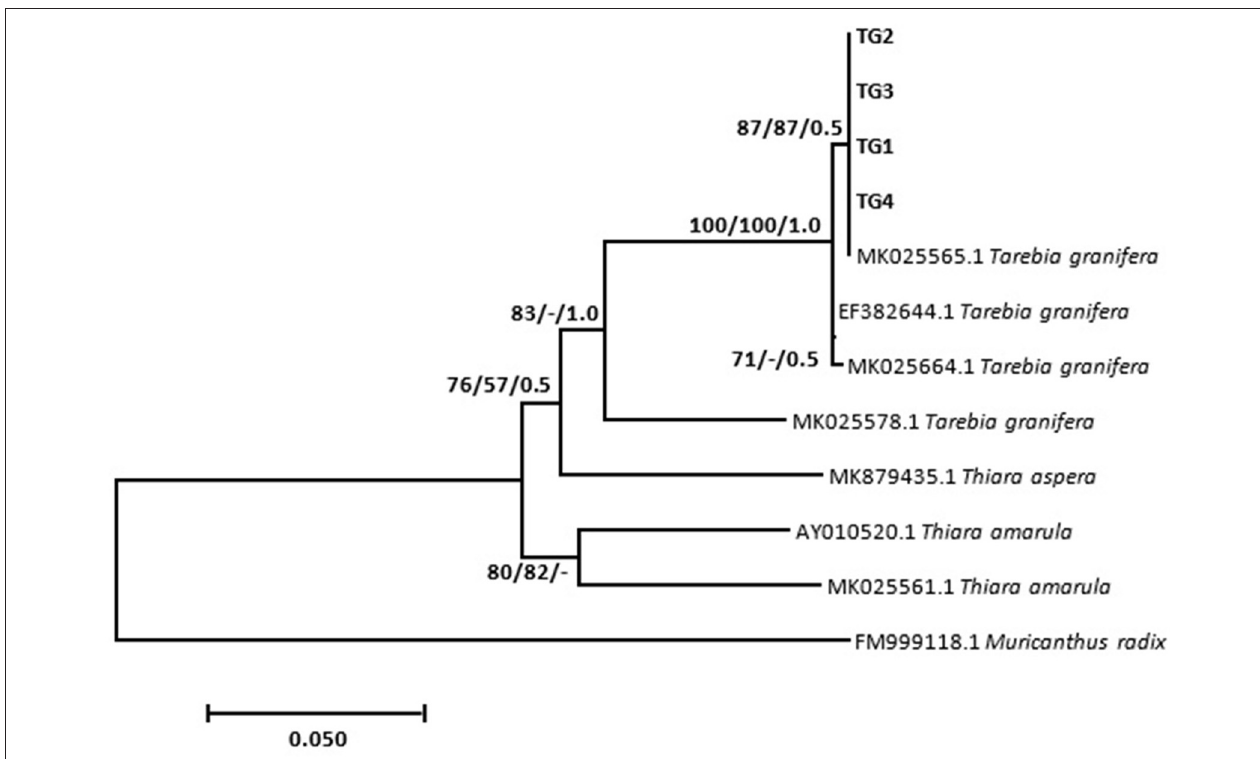
FIGURE 2 | Neighbor-joining tree based on the 481-nucleotide sequence of the 16S rDNA, confirming the identity of Tarebia granifera (TG1–4) (in bold) collected from Mpumalanga province of South Africa and their relationship with other Thiaridae species obtained from the NCBI GenBank database. The support value indicated on the nodes follows the order neighbor-joining bootstrap value/maximum likelihood bootstrap value/Bayesian inference posterior probability.